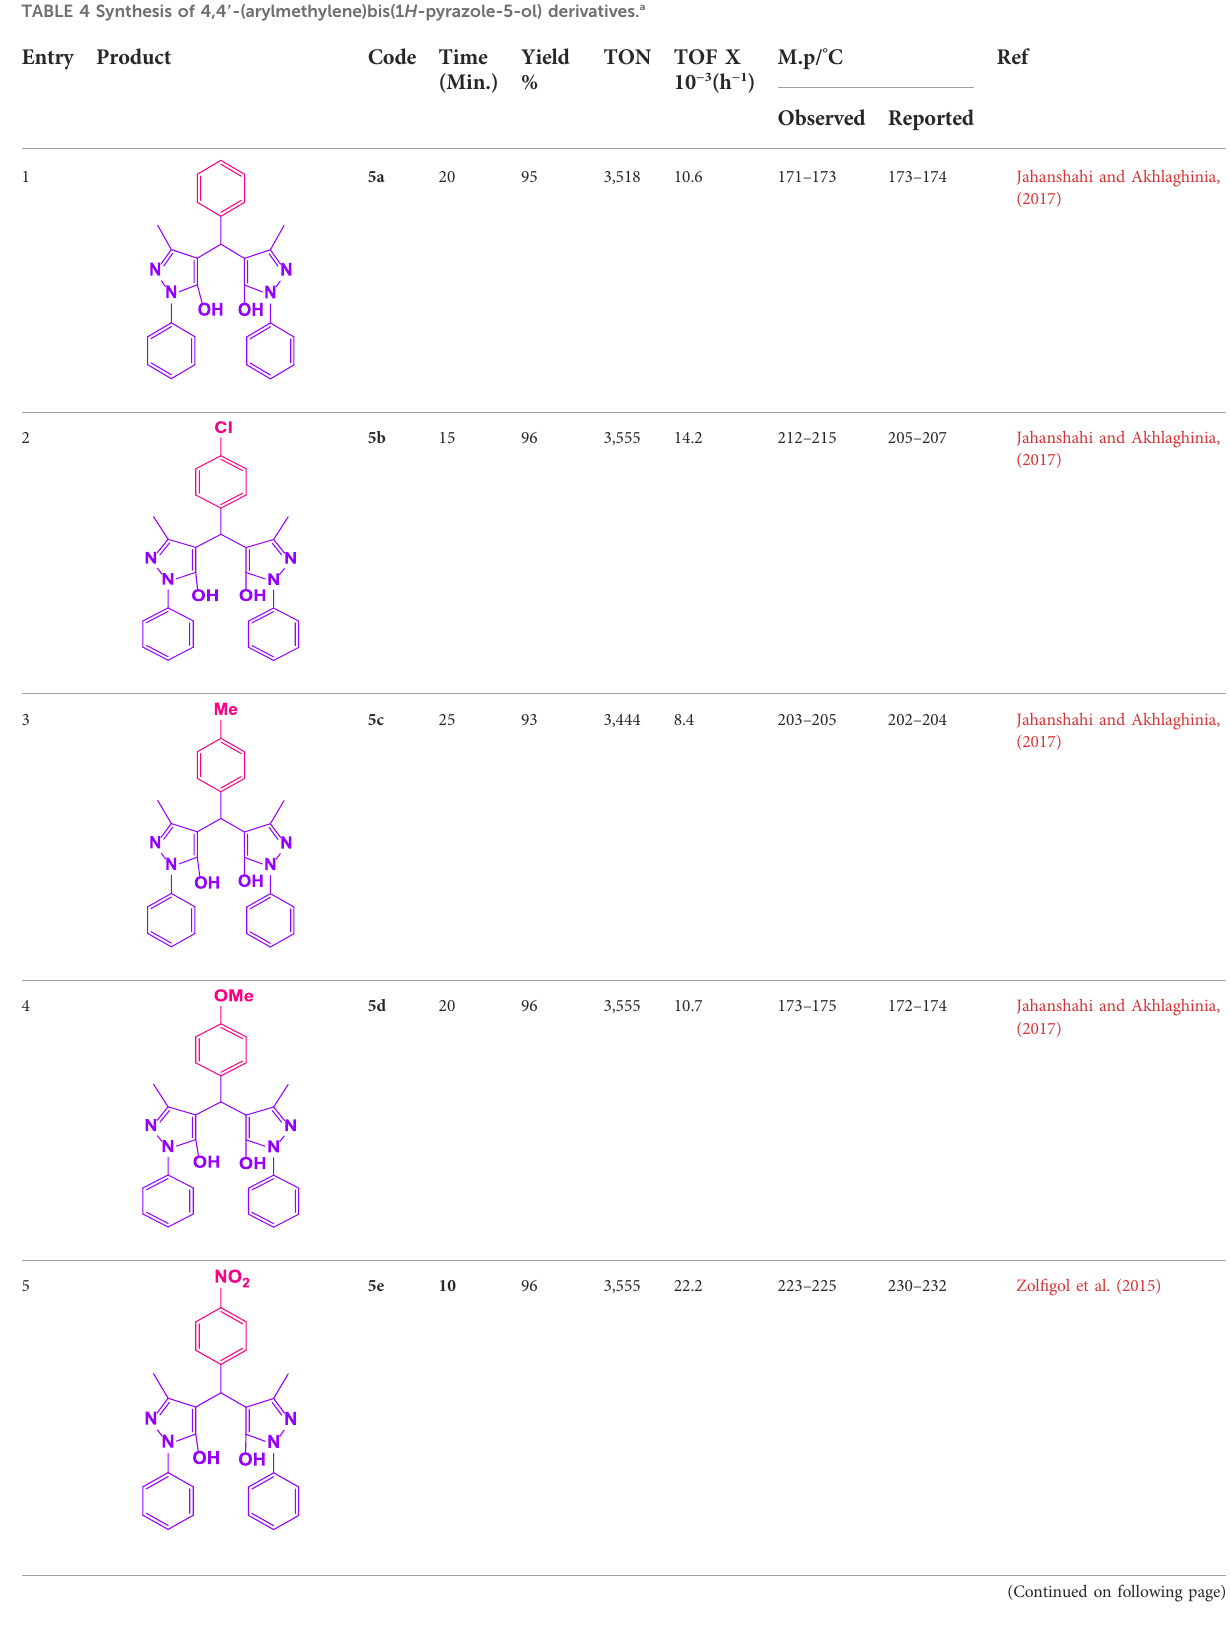
TABLE 4 Synthesis of 4,4 9 -(arylmethylene)bis(1 H -pyrazole-5-ol) derivatives. a